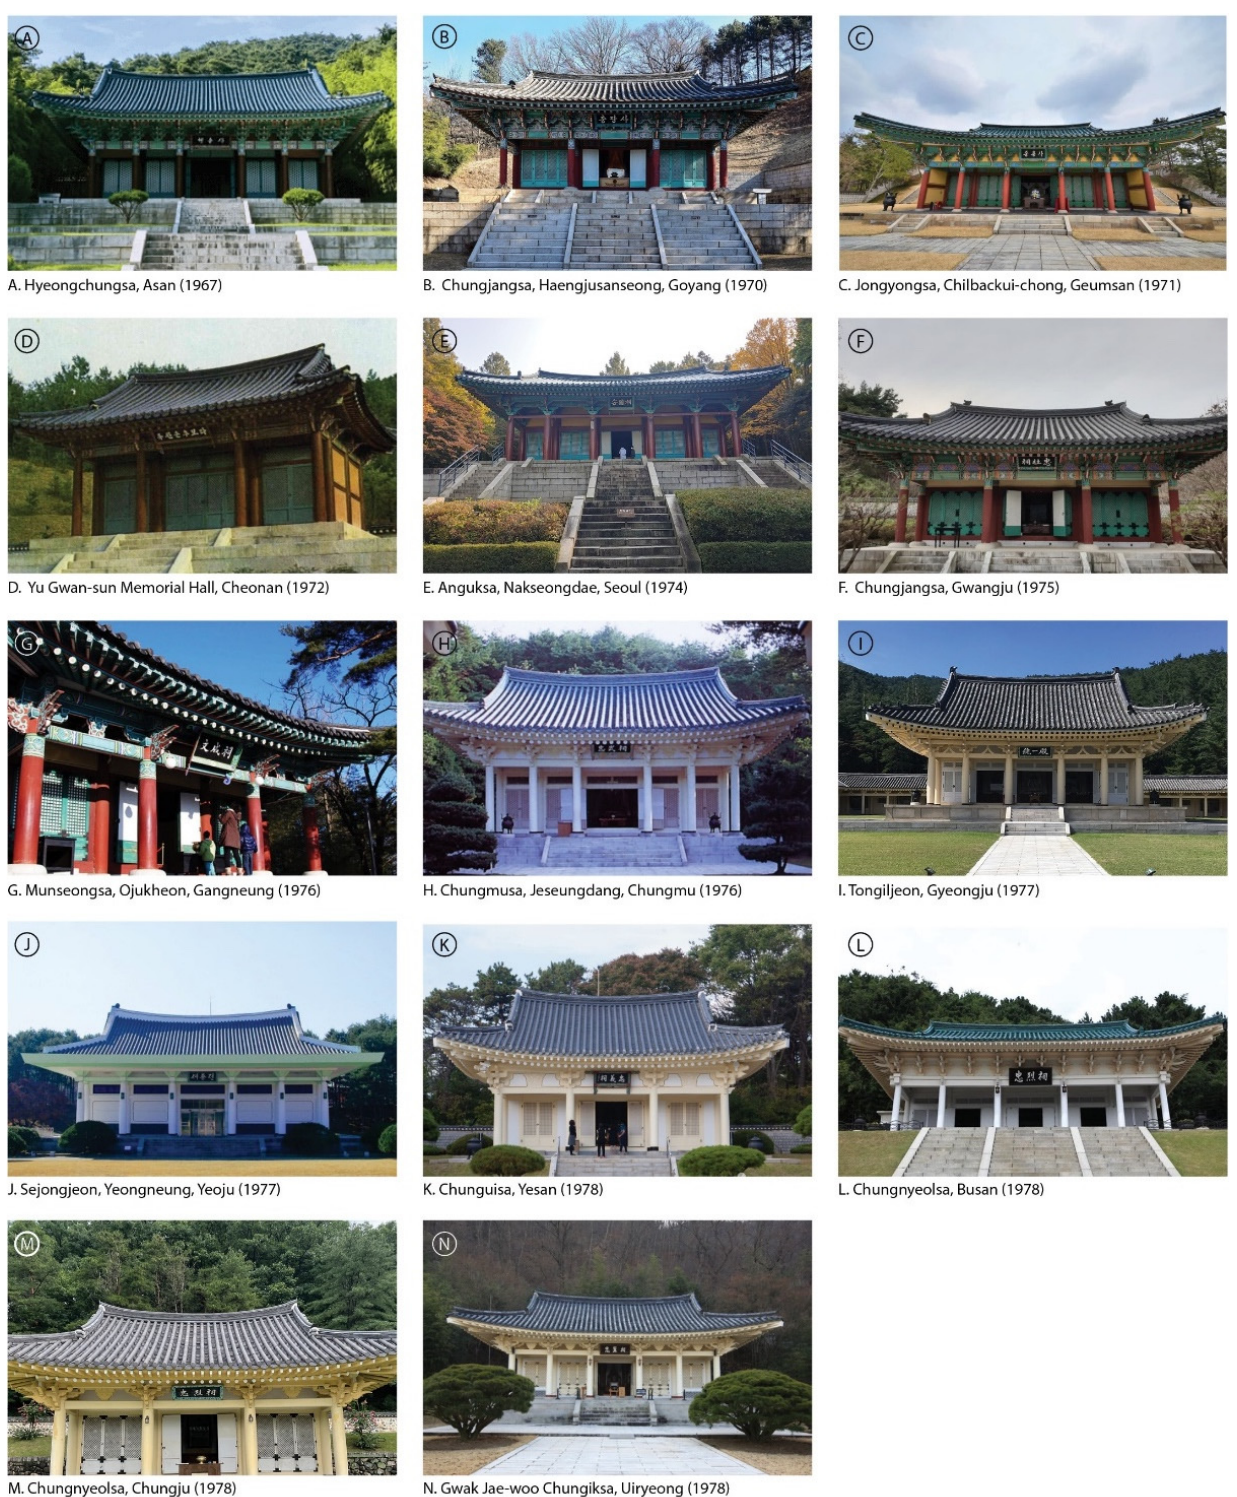
Figure 1. Fourteen Newly Built ‘National Shrines’ with Similar Appearance.